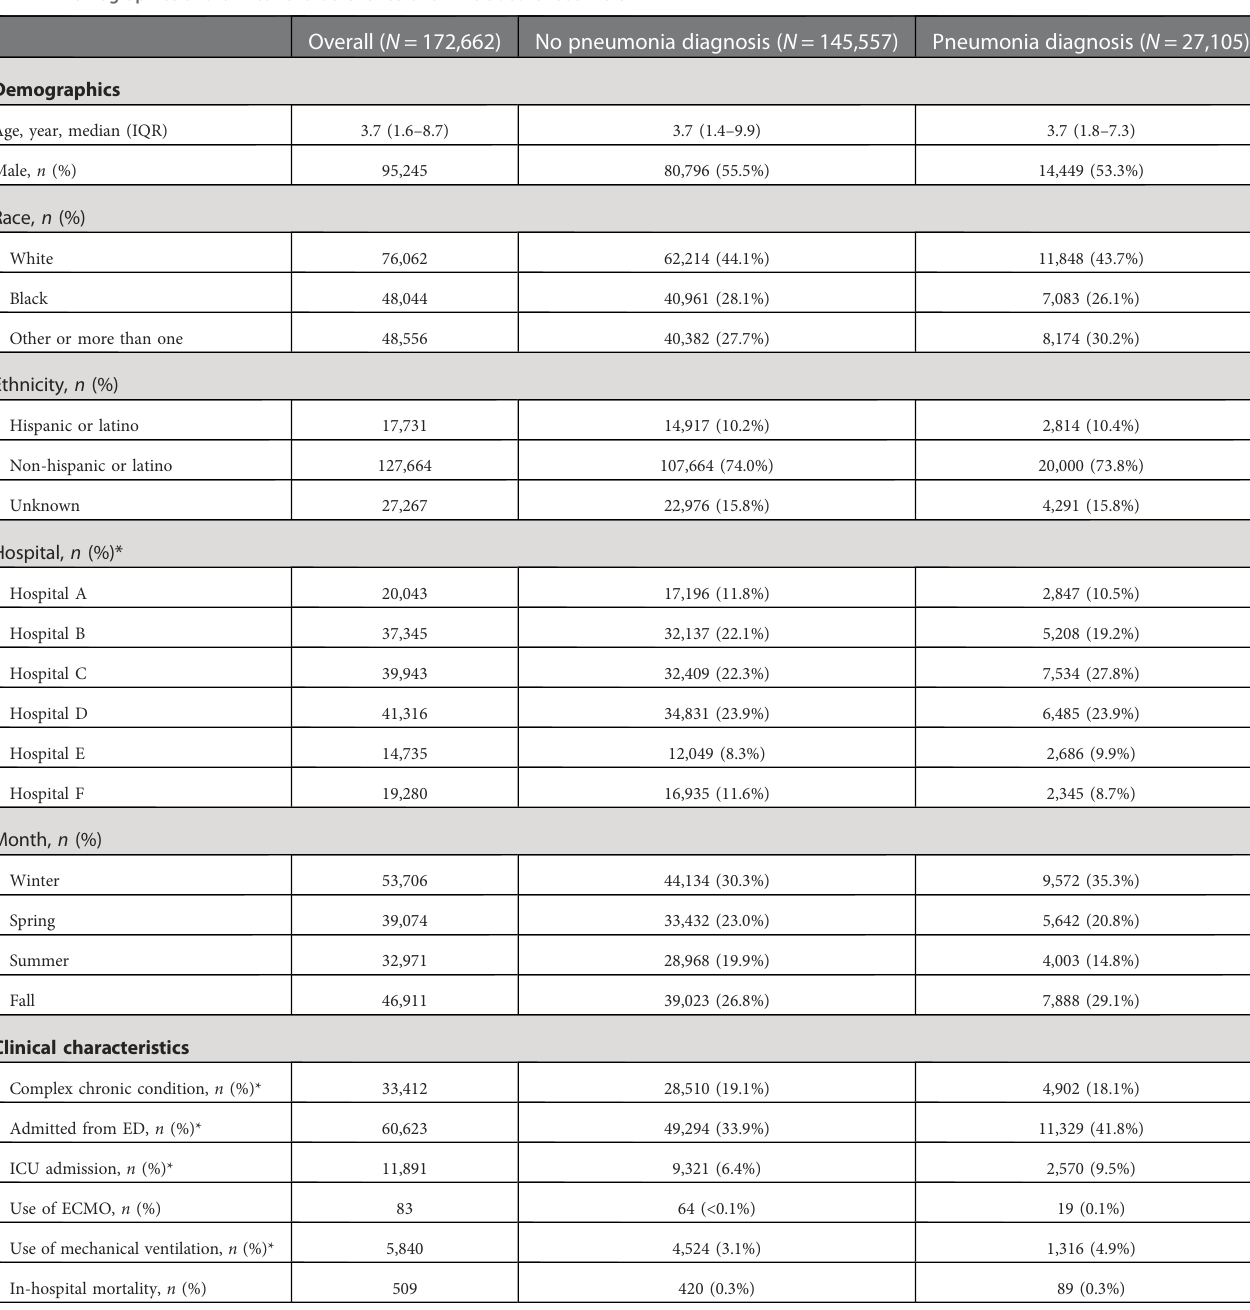
TABLE 2 Demographics and clinical characteristics of all included